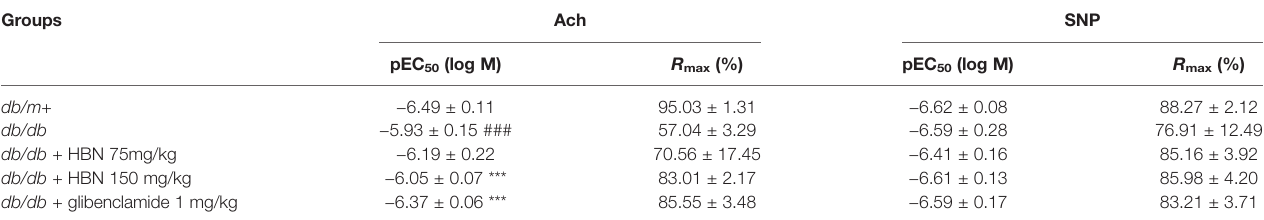
TABLE 2 | Agonist sensitivity (pEC50) and % maximum relaxation ( R max ) of acetylcholine-induced endothelium-dependent relaxation and sodium nitroprusside (SNP)- induced EIR in isolated aorta from db/db mice treated with glibenclamide (1 mg/kg), HBN (75 mg/kg) and HBN (150 mg/kg). Groups